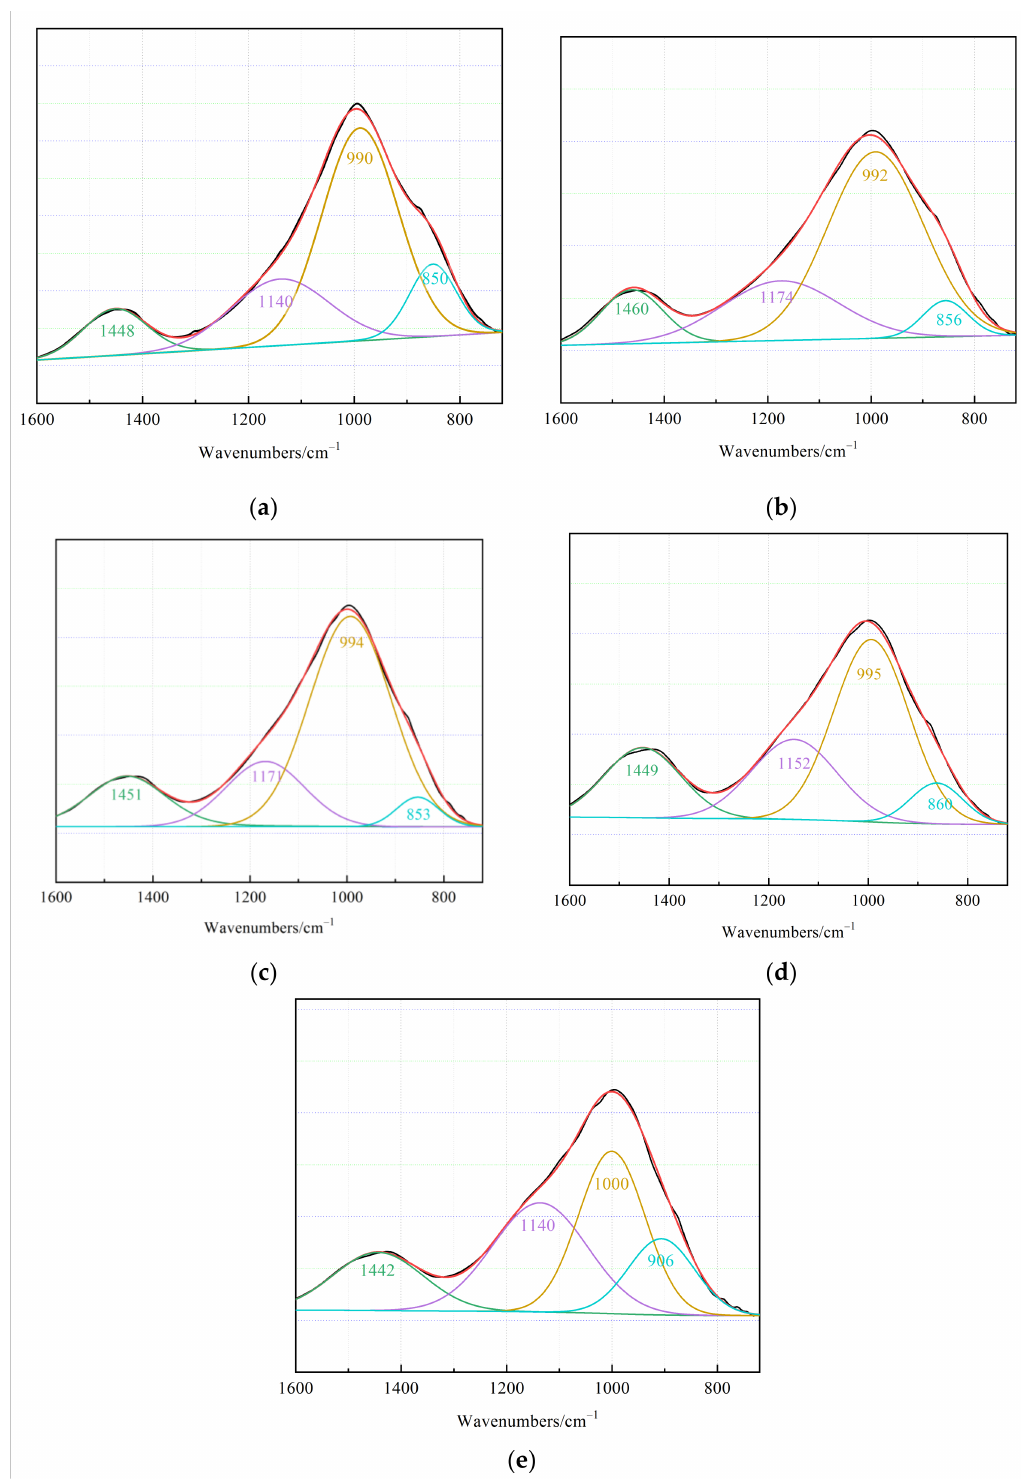
Figure 11. Deconvolution diagram of asymmetric stretching vibrations for the Si–O–T bonds of C–S–H and C–A–S–H at different CPB sample ages with the optimal mix ratios: ( a ) 1 day, ( b ) 3 days, ( c ) 7 days, ( d ) 14 days, and ( e ) 28 days. However, we found that the Si–O–T peak (Q 3 ) near 990 cm − 1 and the C–O stretching vibrational peak (Q 4 ) near 870 cm − 1 shifted to higher wavenumbers, indicating a decreasing degree of polymerization for the carbonated C–A–S–H. The degree of polymerization